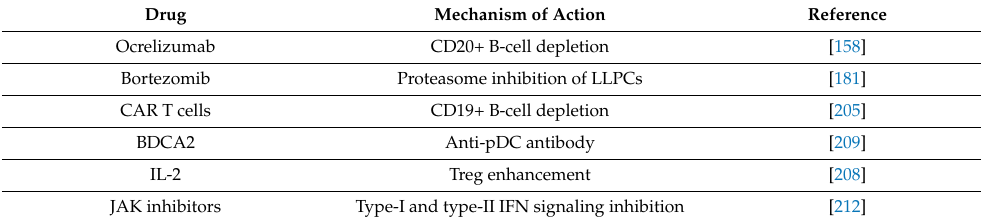
Table 2. Promising future therapies for